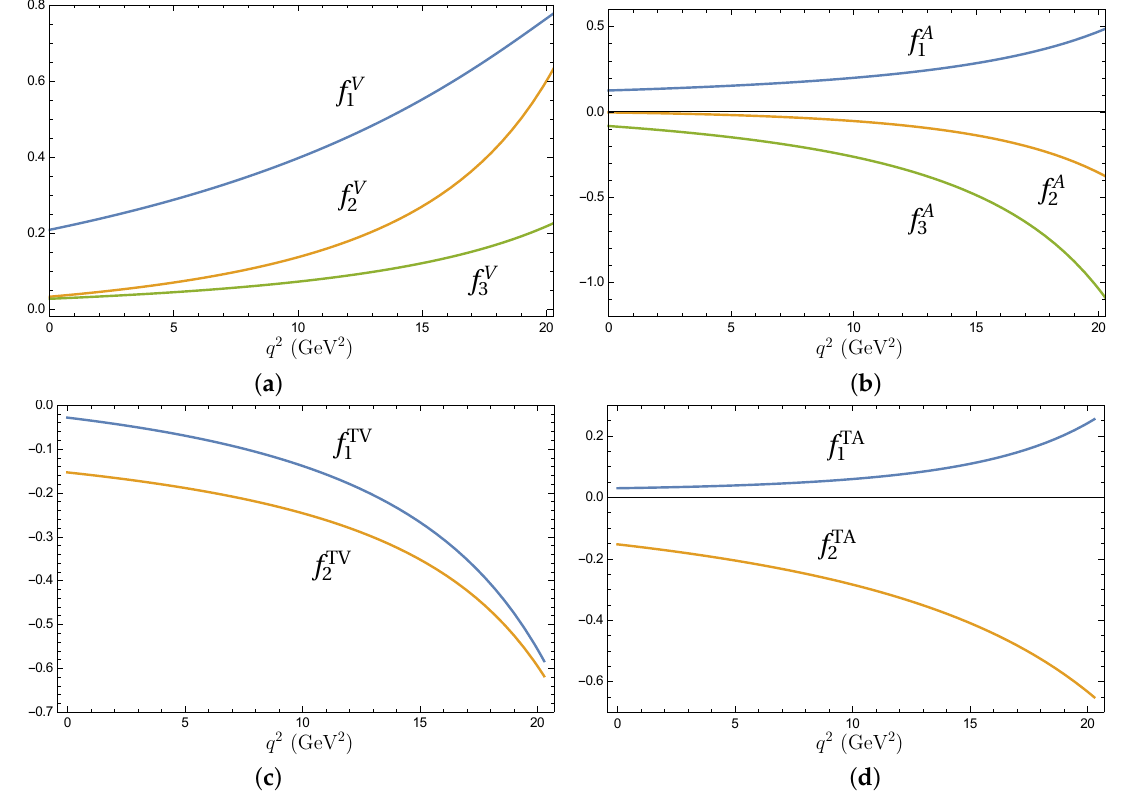
Λ transition parameterizing vector ( a ), axial vector ( b ), →